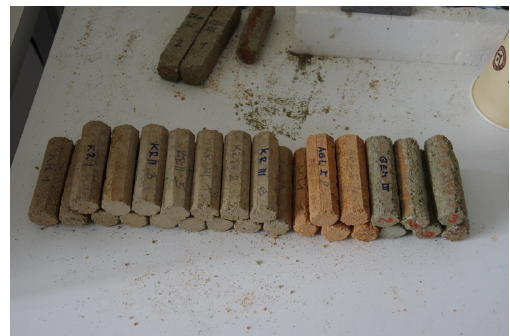
Figure 5. The test bodies shape of prism with octa- hedron base. Figure 6.